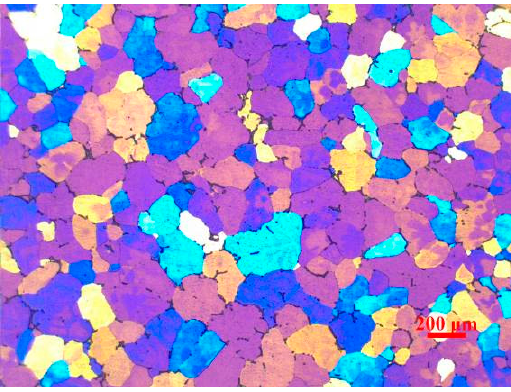
Figure 1. Original optical microstructure of the Al–4.8Mg alloy.